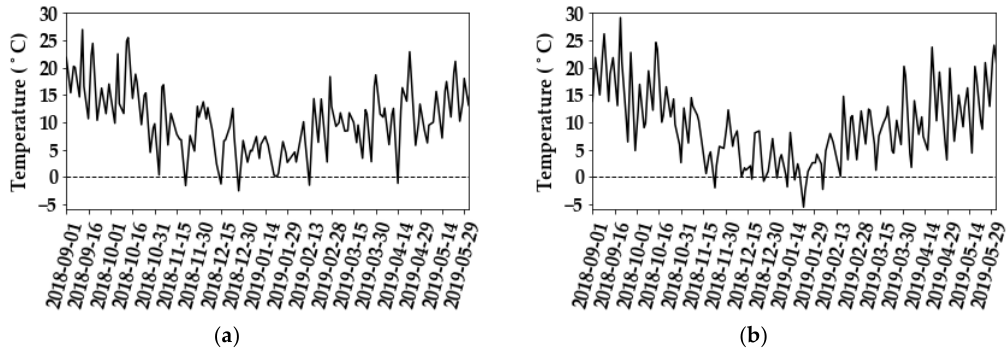
Figure 2. Temperature profiles over our study sites. ( a ) Study site A and ( b ) study site B.